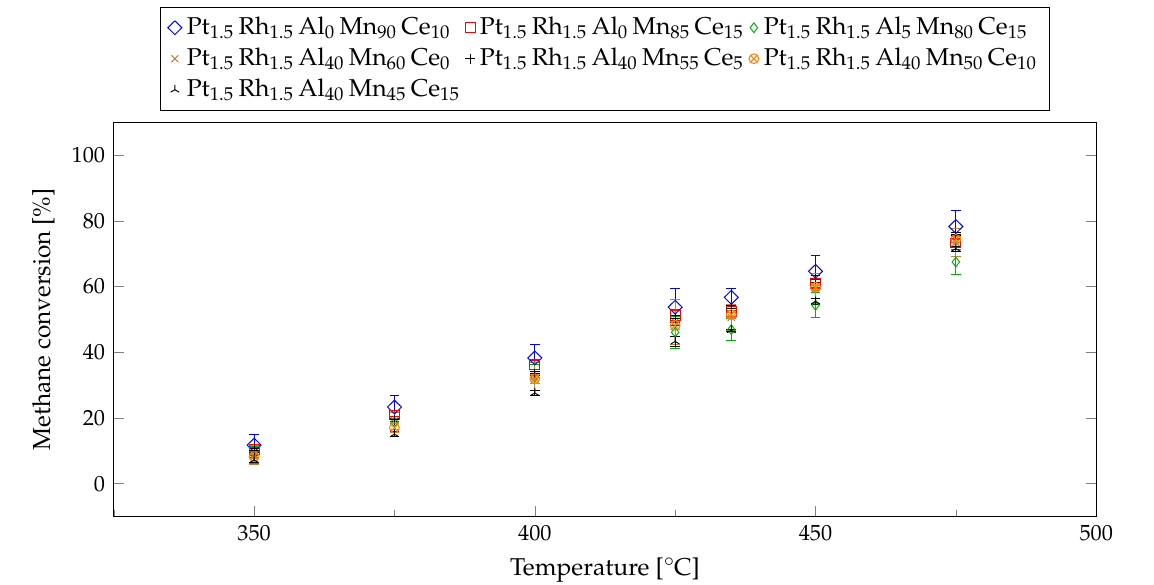
Figure 14. Methane conversion at different temperatures for samples from from composition range Pt 1.5 Rh 1.5 Al a Mn b Ce c from Table 3. 12.5vol.% H 2 O, 12.5vol.% CO 2 , 9.0vol.% O 2 , 0.25vol.% CH 4 , 0.055vol.% CO, 0.012vol.% NO, 0.004vol.% NO 2 , 0.001vol.% SO 2 , balance He, WHSV = 36,000mL/ ( gh ) . Error bars represent standard deviation ( n = 3) as given by Equation (2).